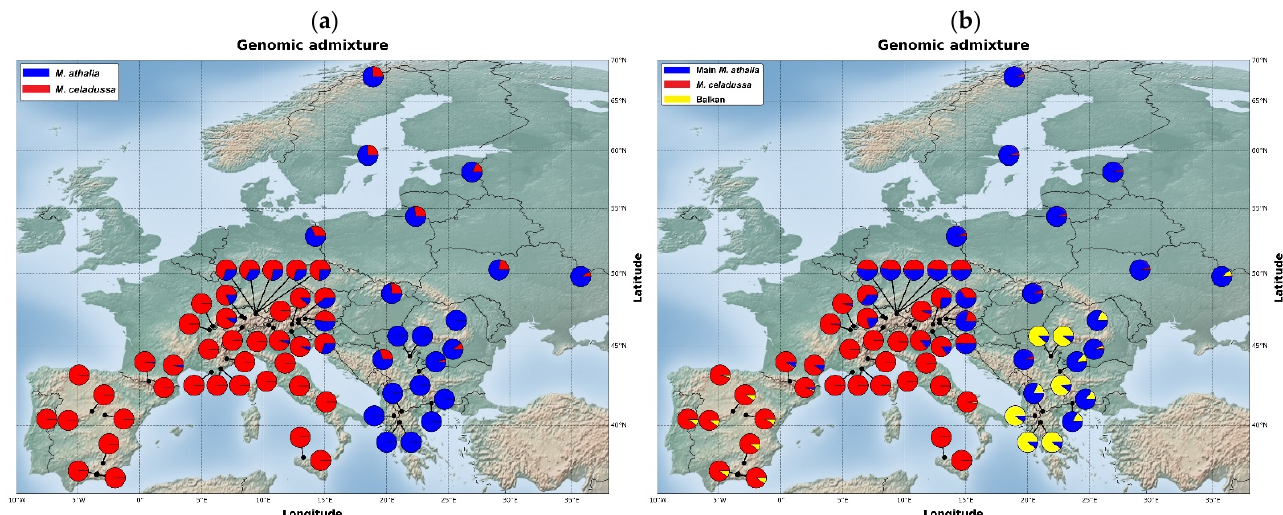
Figure 3. Pie chart map following STRUCTURE results of K = 2 ( a ) and K = 3 ( b ) based on ddRAD data, showing individual genomic admixture of M. celadussa – M. athalia according to geographic location.